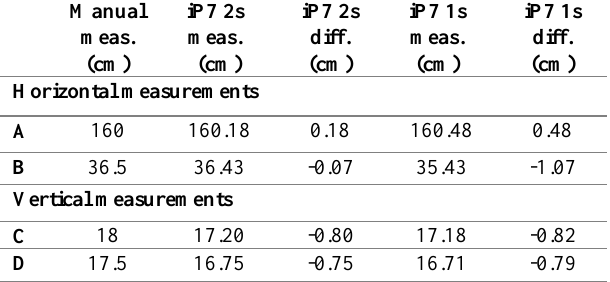
Table 9. Dimensions of steps using 3D point clouds generated with pre-calibrated iPhone 7; using full set of images vs reduced set of images.